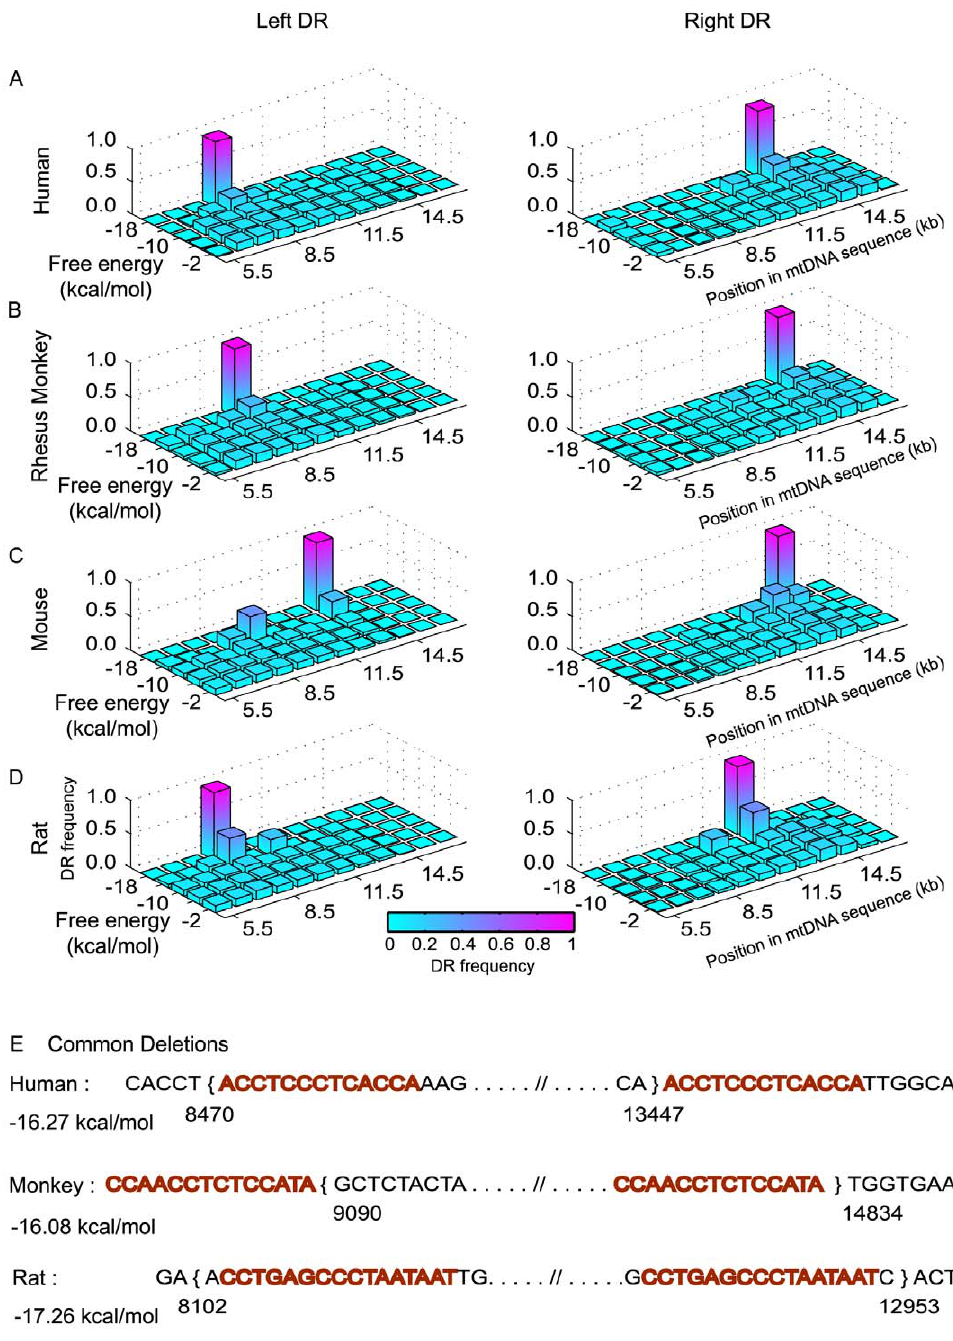
Figure 4. Free energy and position wise distribution of the DRs in mtDNA major arc. Resolution of DR distribution based on DR free energy and position in mtDNA sequence of (A) human, (B) rhesus monkey, (C) mouse and (D) rat. The x- and y- axis values denote the midpoint of each corresponding bin, i.e. a bin centered at 5.5 kb denotes a range from 5 to 6 kb and similarly, a bin centered at 2 2 kcal/mol has a range between 0 to 2 4 kcal/mol. (E) The most stable DR motifs in mtDNA major arc are associated with reported common deletions. Left and right breakpoint positions (denoted by open and close braces respectively) of common deletion [18,27,28], the flanking DR sequence (highlighted in red) and the calculated DR free energy value in human, rhesus monkey and rat